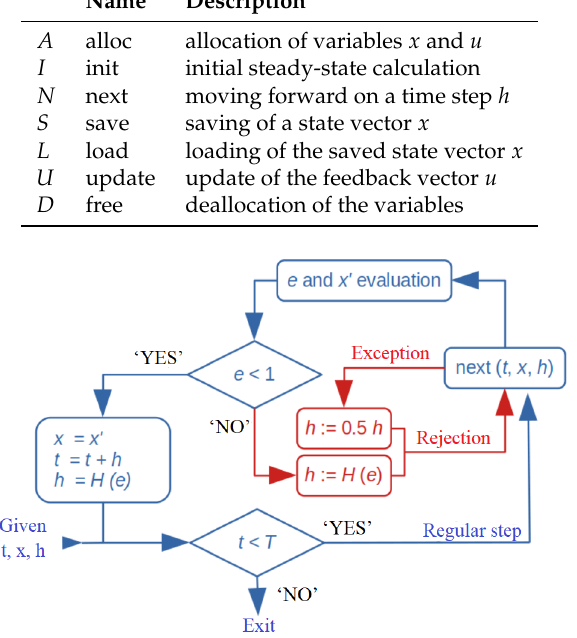
Figure 2. Time step processing